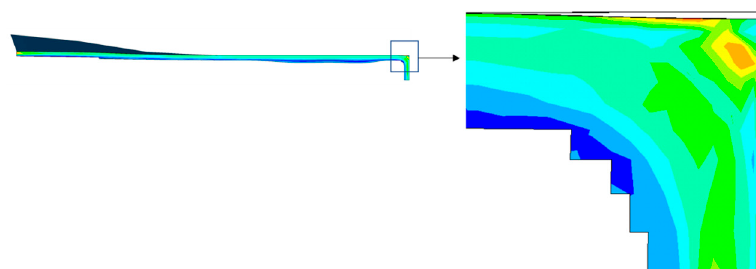
Figure 4. Mold outlet gap.